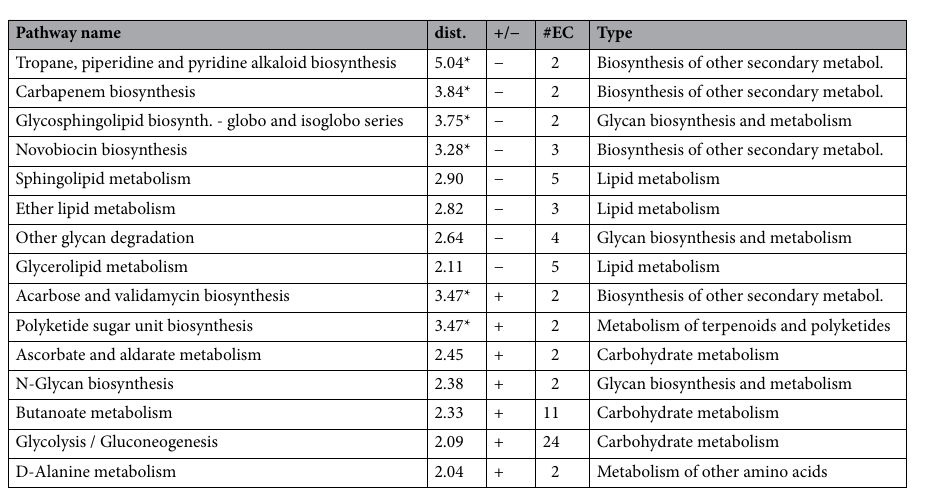
Table 1. Altered pathways in COVID-19 The most differential pathways in COVID-19 (with dist. ≥ 2 ) are shown in the table. Here dist. denotes the pathway score’s distance from the median, divided by the scaled median absolute deviation. Pathways that are determined outliers (dist. ≥ 3 ) are marked with *. The direction of the change in COVID-19 (+/−), the number of associated EC features per pathway detected from functional profiling (#EC), and the pathway type are also